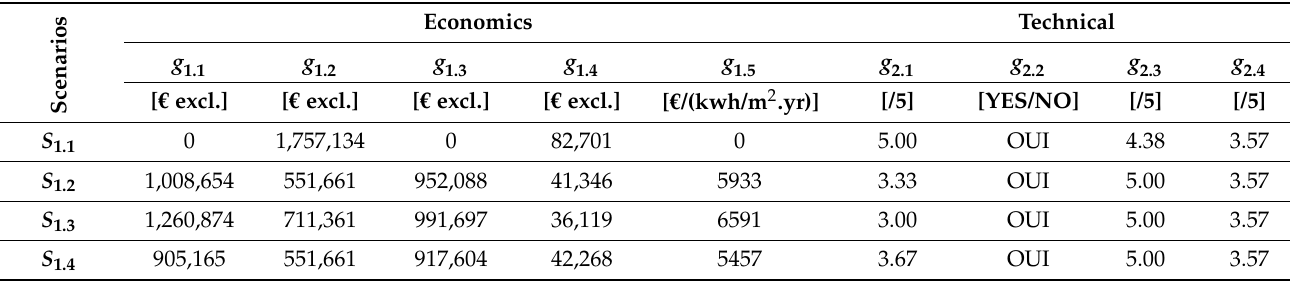
Table 10. Performance matrix for global retrofit scenarios—(part